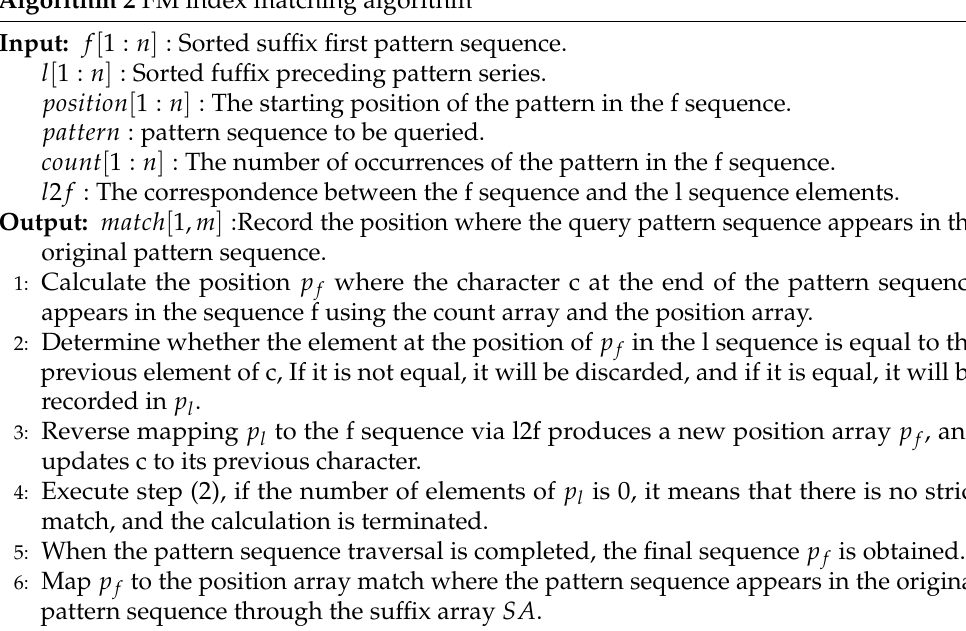
Algorithm 2 FM index matching